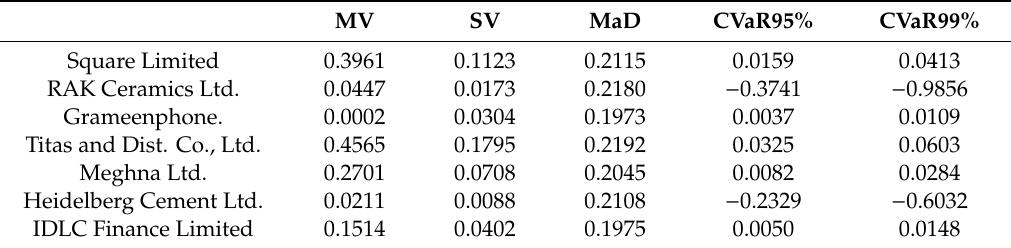
Table 4. Optimal portfolio compositions for economic crisis period